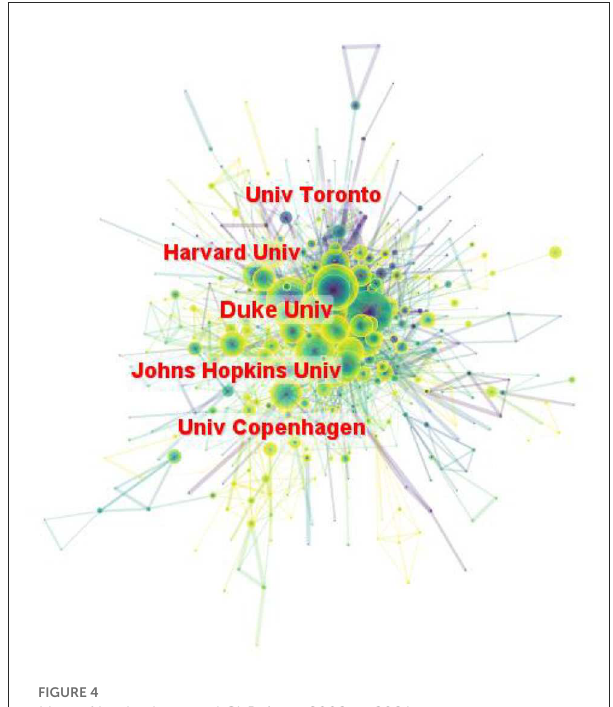
TABLE 2 The top 10 countries/regions on LChD from 2002 to 2021.